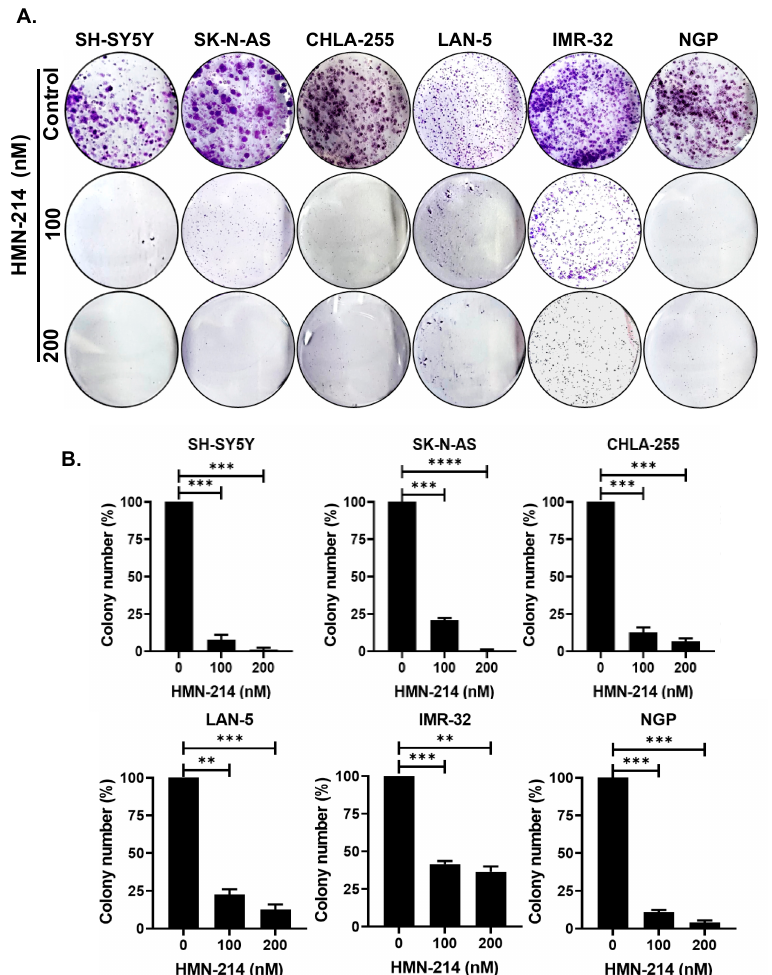
Figure 3. HMN-214 inhibits NB colony formation. Colony formation assay in response to HMN-214 in six NB cell lines. ( A ) Representative images of colony formation assays. ( B ) Quantitative representation of relative inhibition of colony formation. ** p < 0.01, *** p < 0.001, and **** p < 0.0001.